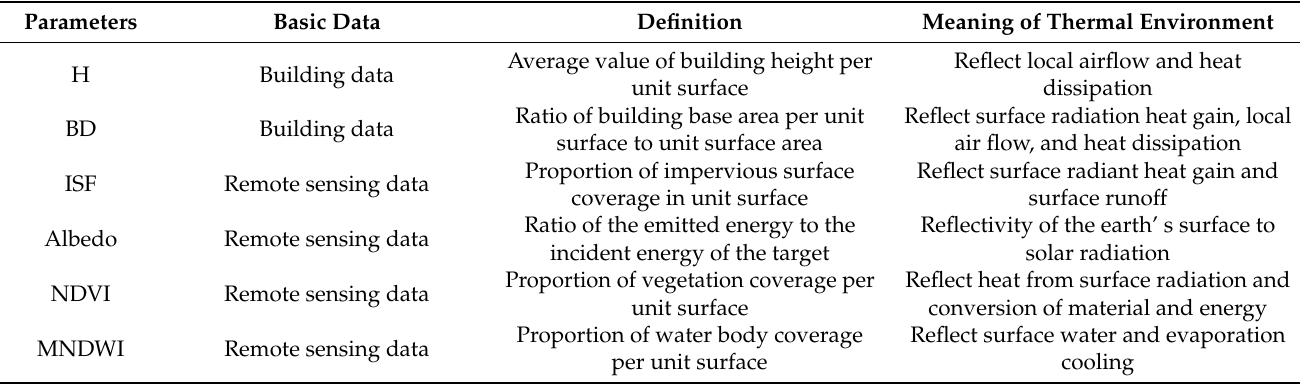
Table 3. Definition and description of urban form